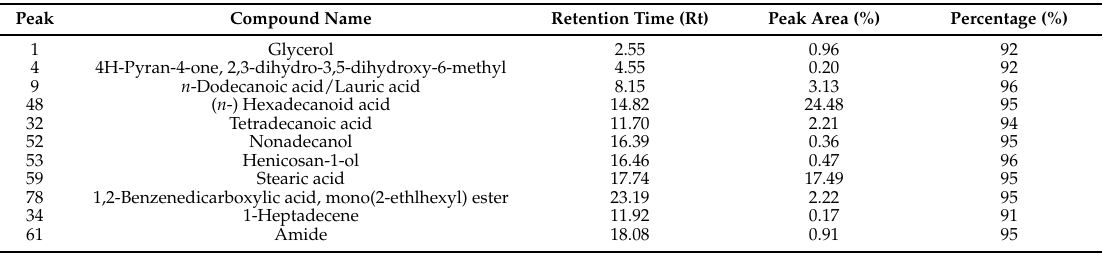
Table 7. Results of GC-MS analysis conducted to identify compounds from the E60 extract.